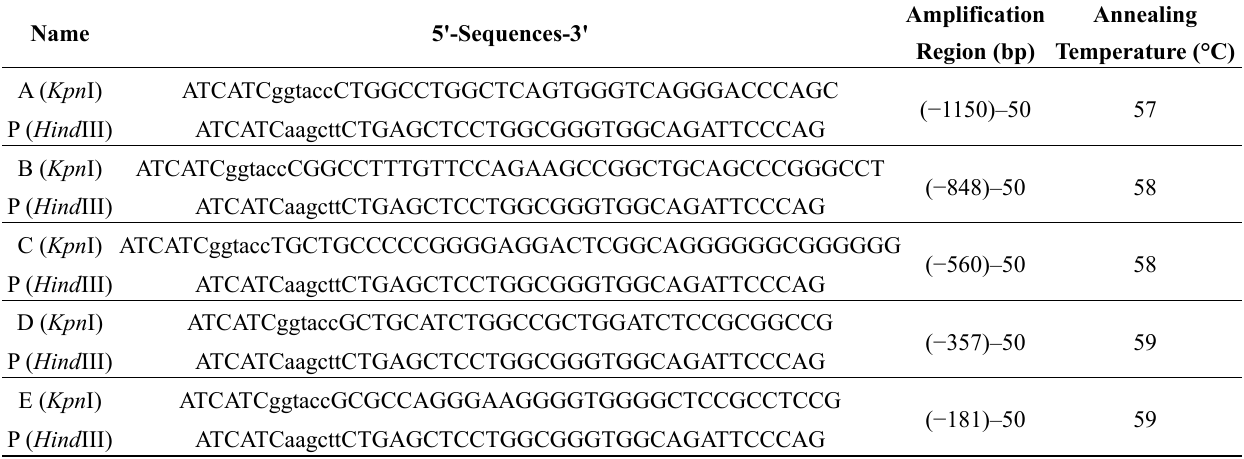
Table 1. Primer sequences of different lengths of FUT1 gene promoter. P is the shared reverse primer, and A, B, C, D and E respectively represents the forward primers used for producing PCR fragments with different length. The lower case letters are the recognition site of the restriction